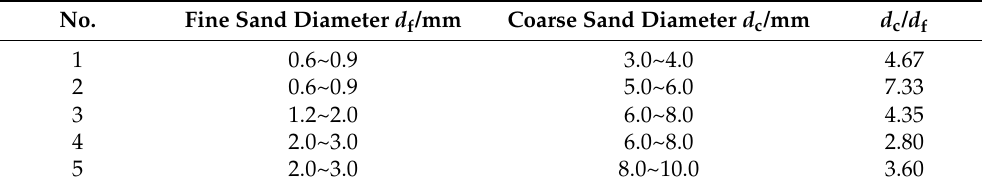
Table 1. Sediment diameter and